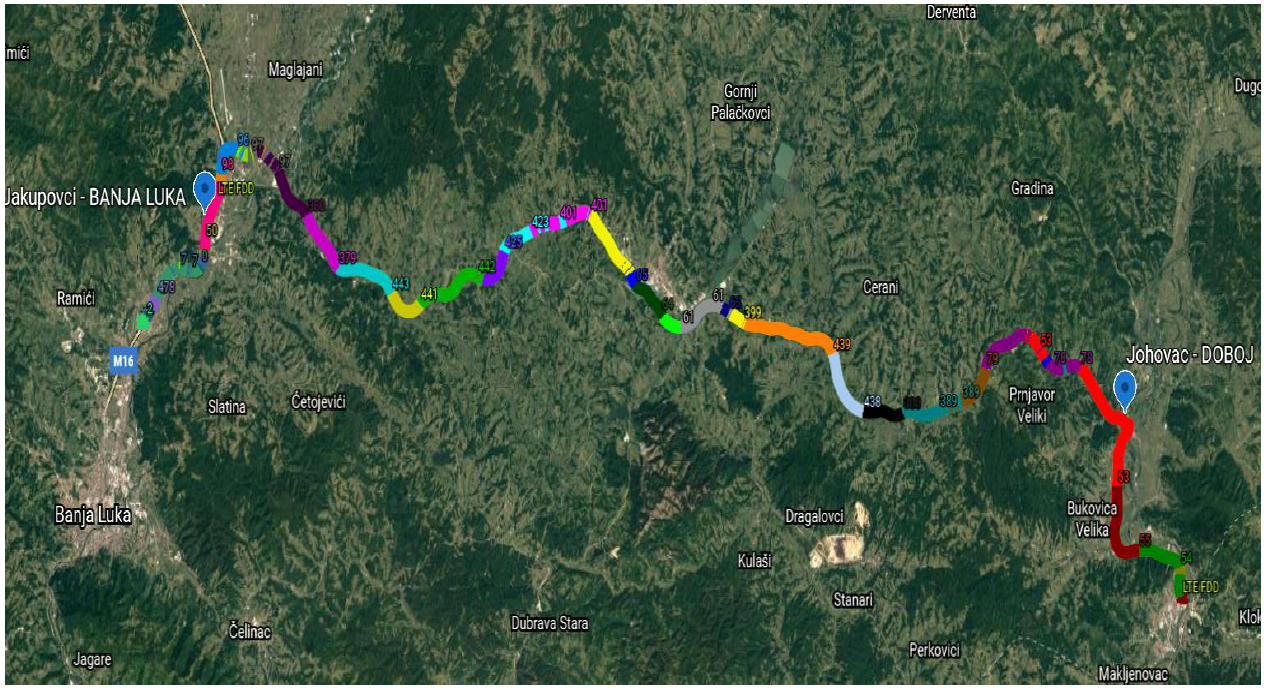
Figure 2. A view at the topology of the coverage of the M9J segment with LTE network technology cells.